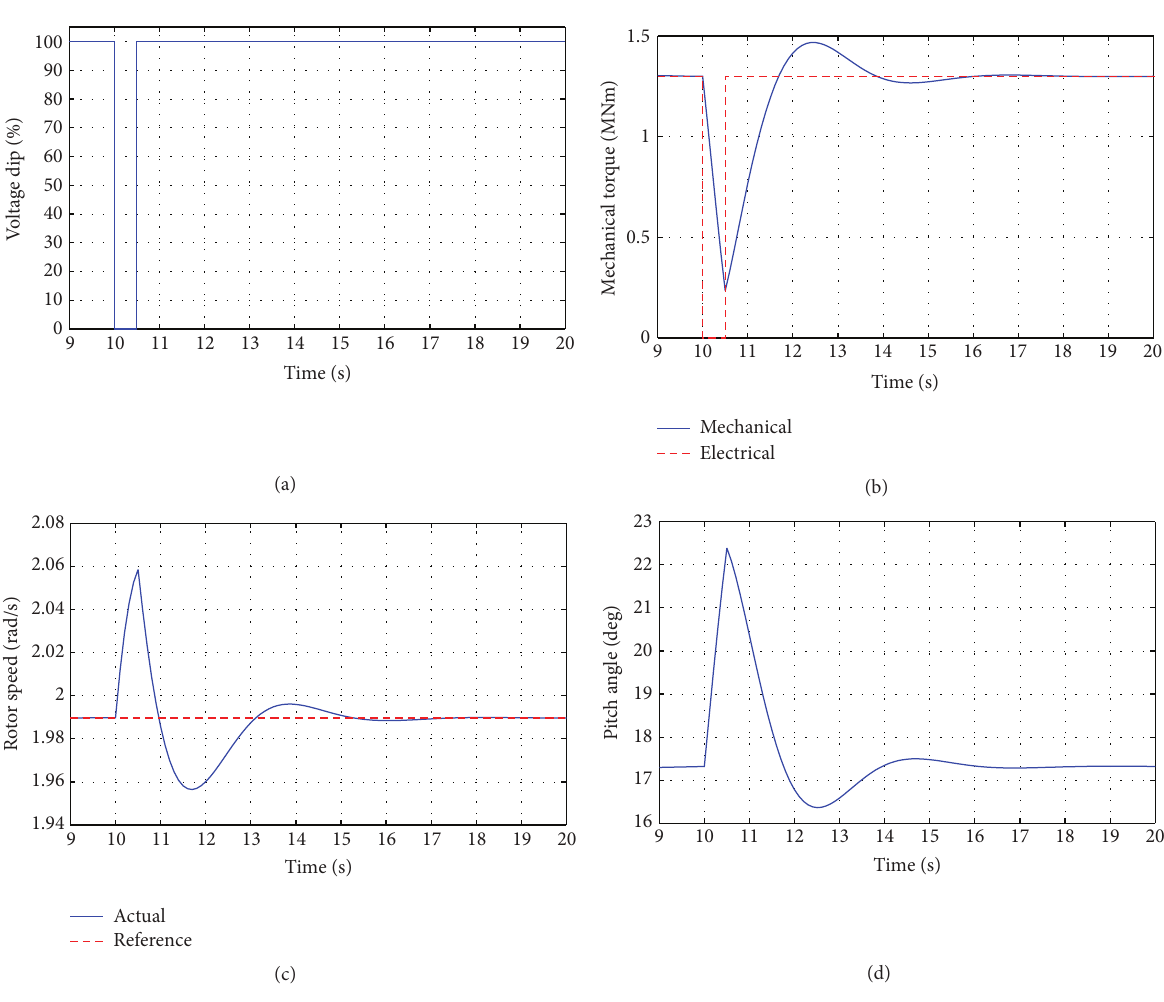
Figure 10: Step response of the pitch regulated WT system under 100% voltage dip: (a) power level, (b) output torque, (c) rotor speed, and (d) pitch